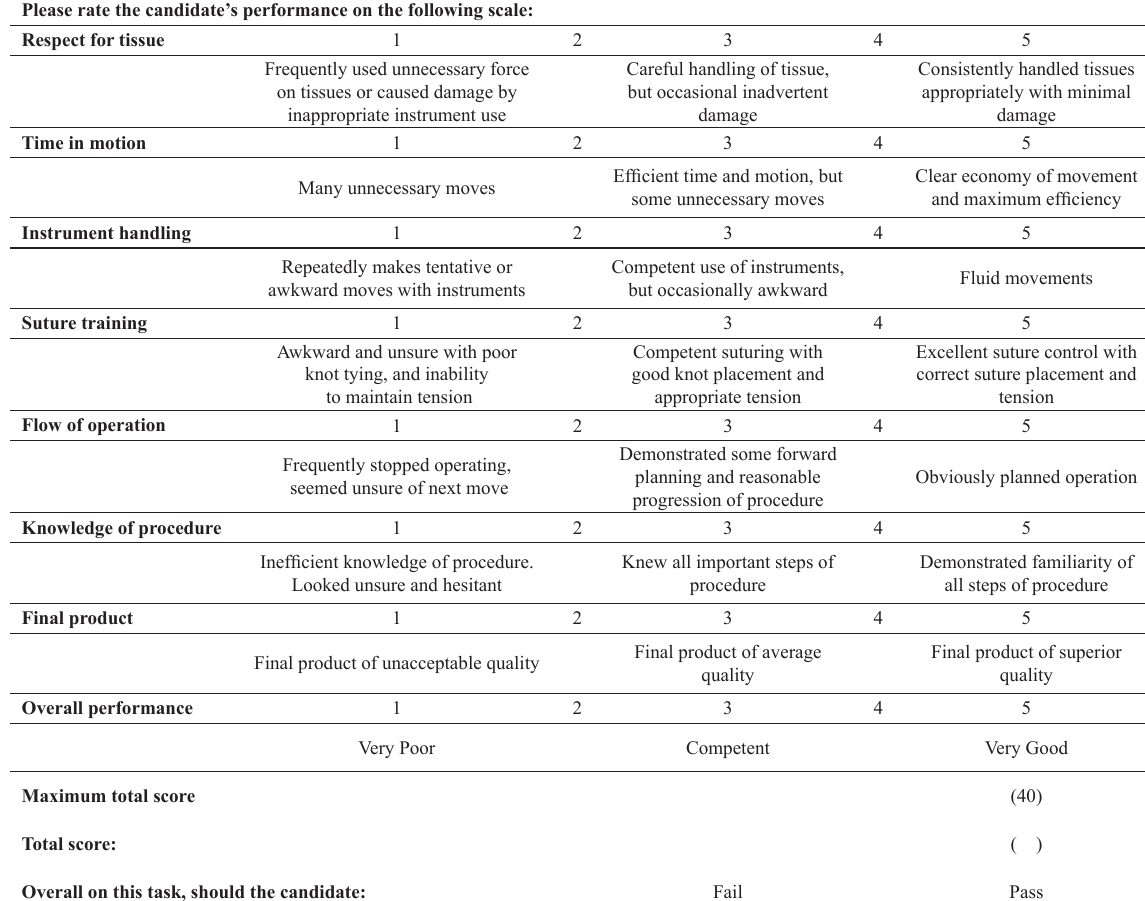
TABLE 1 – Global Rating Scale 6,7